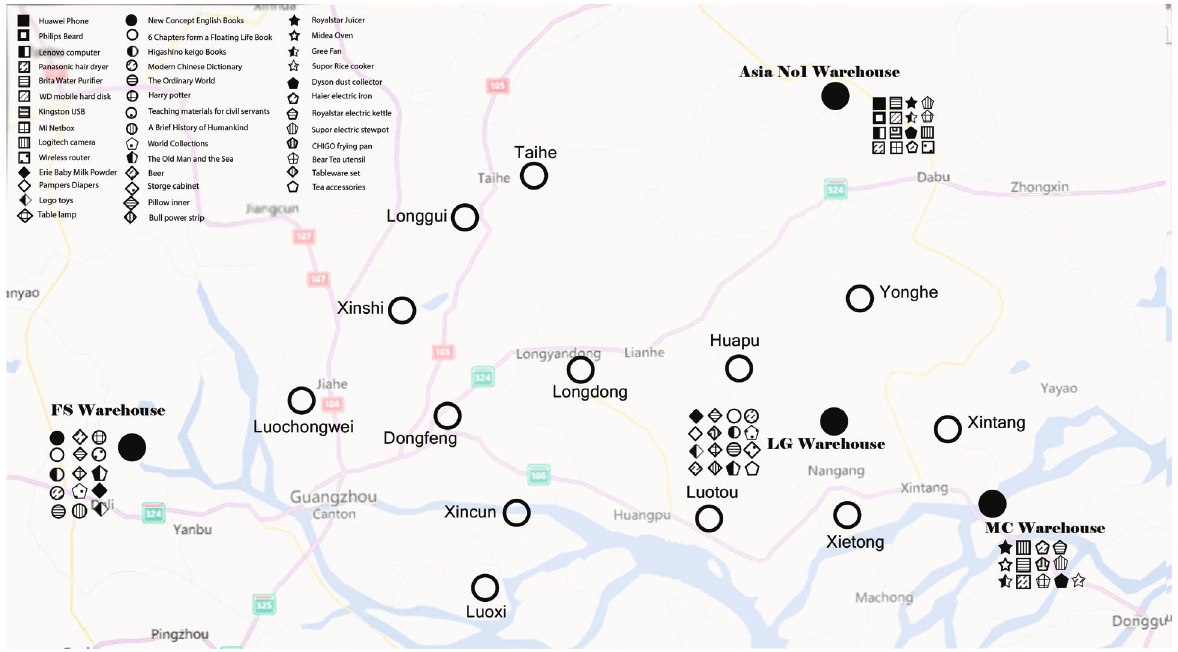
Figure 10: Real-world instance: locations of warehouses and stations points. Table 3: Results on real-world instances: the JD.com